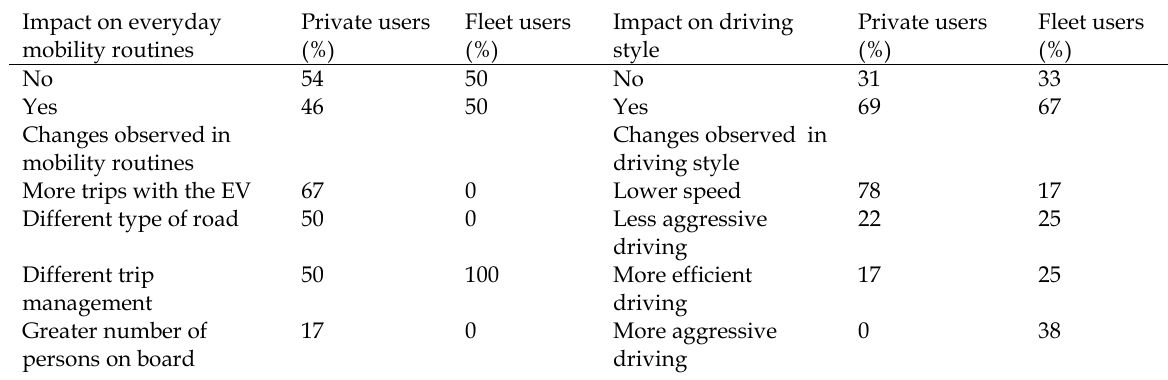
Table 7 Impact on everyday mobility routines and driving style (percentage of